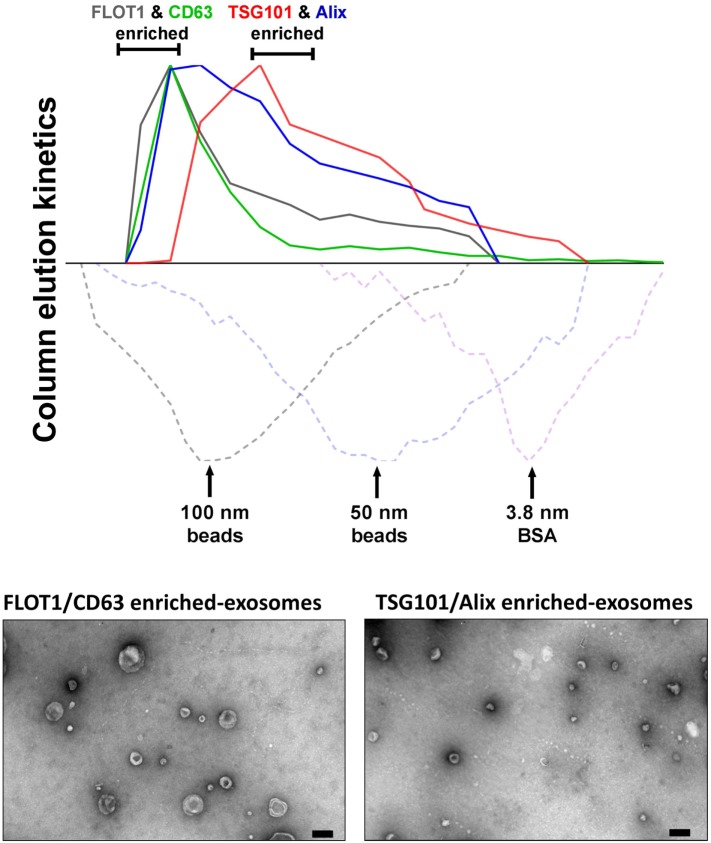
Isolation of MSC-exosomes subtypes by size-exclusion chromatography (SEC). Briefly, exosomes were isolated directly from cell culture supernatants following a 36 h harvest period in serum-free-media. Cell culture media were subjected to differential centrifugation, 300 × g for 10 min, followed by 3,000 × g for 10 min, and 13,000 × g for 30 min to remove any cells, cell debris, and large apoptotic bodies in suspension, respectively. Conditioned media (CM) was concentrated 50-fold by tangential flow filtration (TFF) and the exosomes were purified using OptiPrep™ (iodixanol) cushion density flotation (3.5 h at 100,000 × g, 4°C), as previously described (8). Heterogeneous exosomes were further purified by size using size-exclusion chromatography (SEC). Here, sepharose CL-2B (80 mL) was washed with 1 × SSPE buffer [containing 1 mM EDTA and 149 mM NaCl in 0.20 mM phosphate buffer (pH 7.4)]. The column was packed with washed sepharose CL-2B to create a column with an internal diameter of 1.6 cm and height of 40 cm. Exosomes (1 ml, corresponding to 60 × 106 MSC equivalents) were added to column with a flow rate of 1 ml/min. Fractions (1 ml) were collected and assessed by dot plots and electron microscopy. The elution kinetics of 100 nm, 50 nm, and bovine serum albumin (BSA) were used to estimate exosome elution kinetics. TSG101, Alix, CD63, and FLOT1 levels were assessed by dot plots and are reported as relative intensity. Here, we identify two distinct MSC-exosome subtypes. The larger exosomes (>80 nm) have a greater flotillin-1 (FLOT1) and CD63 enrichment, while smaller exosomes (<80 nm) have a greater TSG101 and Alix ratio.